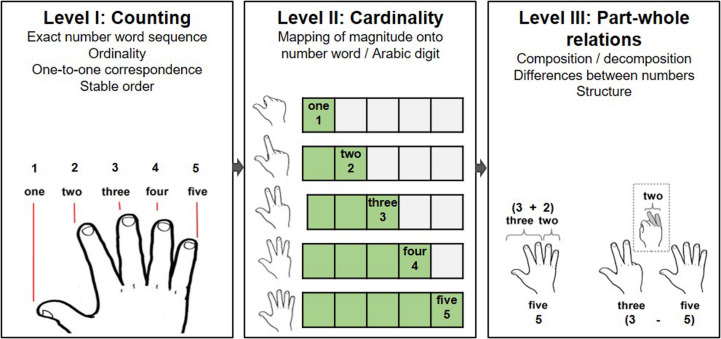
Schematic depiction of how fingers may support acquisition of basic numerical abilities according to influential theories of early numerical development (Gelman and Gallistel, 1978; Brissiaud, 1992; Geary, 2007; Krajewski and Schneider, 2009). Adapted with permission from Roesch and Moeller (2015).